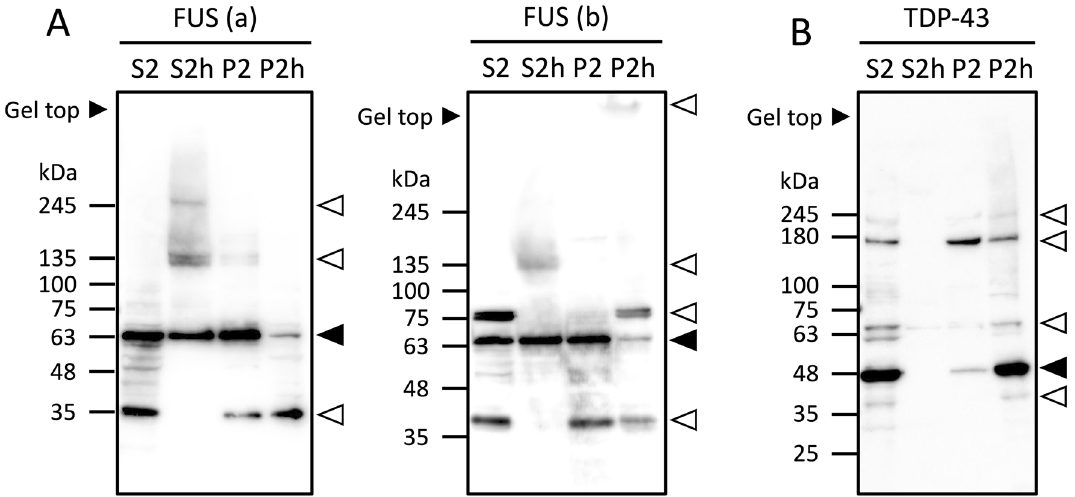
Figure 4. Western blot analysis of FUS and TDP-43. (A) Western blot of each fraction stained with anti-FUS antibodies (a: Proteintech, 11570-1-AP; b: Sigma-Aldrich, HPA008784). (B) Western blot of each fraction stained with anti-TDP-43 antibodies. Black arrowheads are the representative bands of each protein. White arrowheads indicate large sized isoforms and small sized fragments of each